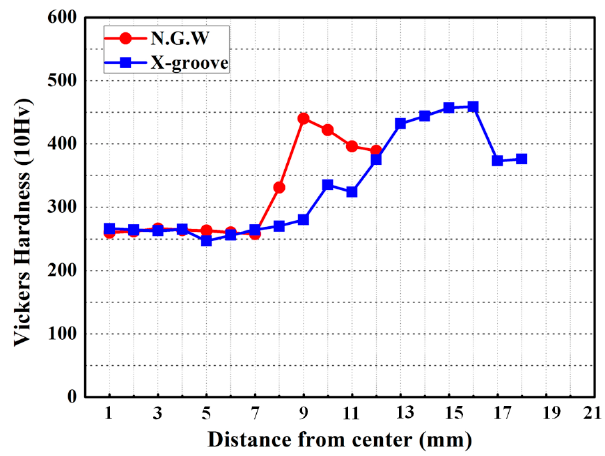
Figure 4. Comparison of hardness distribution.